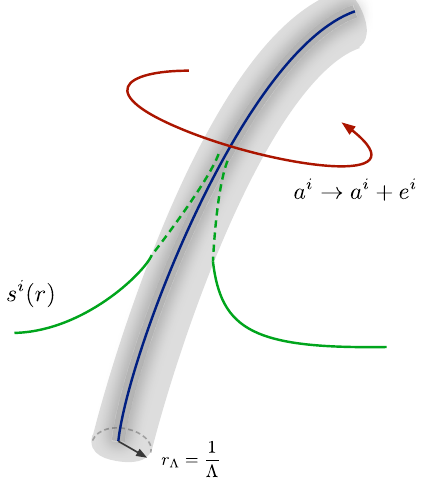
Figure 1 . Axionic string backreaction (2.13a) and (2.13b). In gray, we highlighted the region r ≤ r Λ that cannot be resolved within the